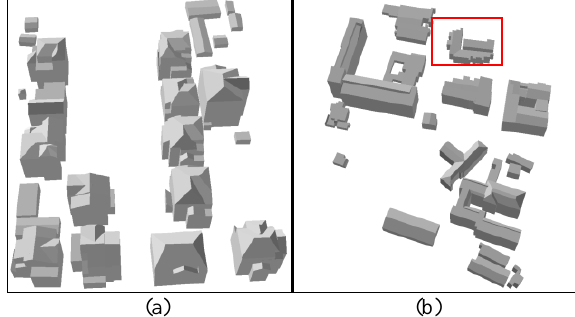
Figure 7 Reconstructed roof models ( β = 0.55): (a) Yangjiang and